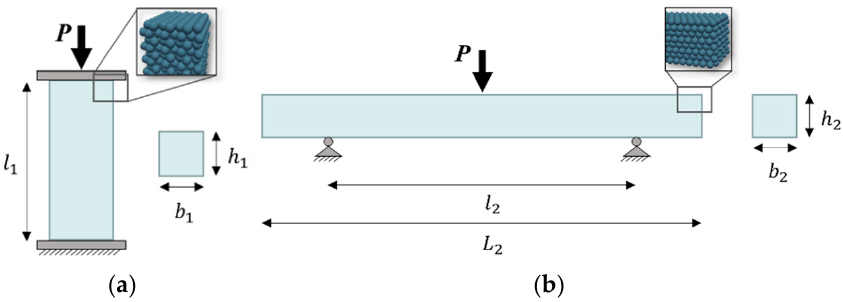
Figure 6. Configuration of simulations: ( a ) uniaxial compressive test; ( b ) three-point bending test.